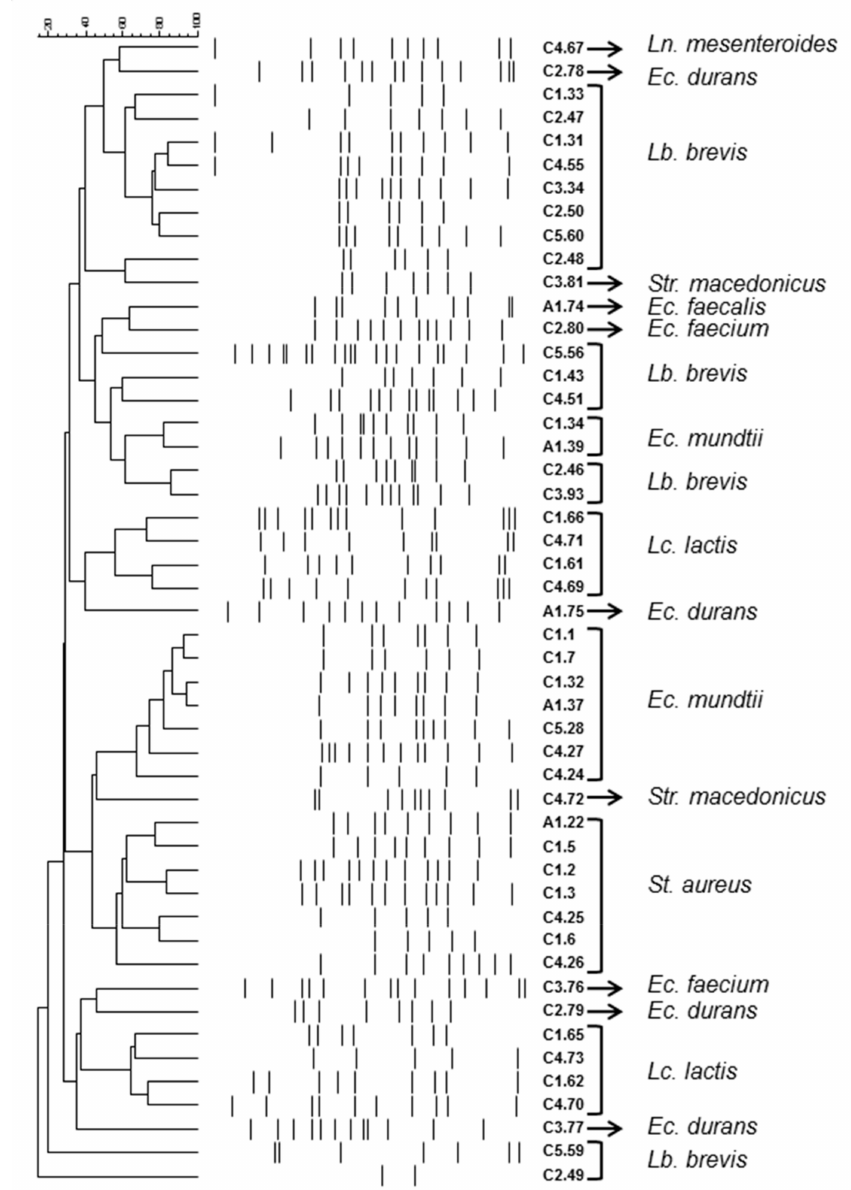
Figure 1. ClusteranalysisofrandomamplifiedpolymorphicDNA-polymerasechainreaction(RAPD-PCR) patterns of the bacterial isolates. Distance is indicated by the mean correlation coe ffi cient (r%) and clustering was performed by unweighted pair group method with arithmetic mean (UPGMA) analysis. Each isolate is named after the origin (C1 to C5; A1) followed by the strain number. Taxonomic a ffi liation was based on sequencing of V1–V3 region of 16S rRNA gene. Ec .: Enterococcus ; Lb .: Levilactobacillus